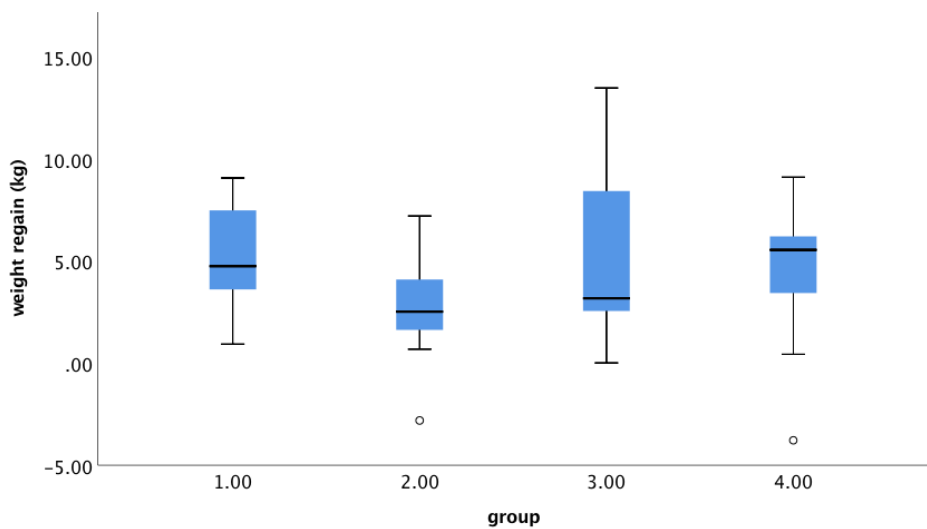
Figure 7. Weight regain in groups of subjects with different combinations of baseline FPG and fibre intake during the FU period. Group 1: baseline FPG < 5.6 mmol/L and fibre intake ≤ median (13.5 g/1000 kcal); group 2: FPG < 5.6 mmol/L and > median fibre intake; group 3: FPG ≥ 5.6 mmol/L and ≤ median fibre intake; group 4: FPG ≥ 5.6 mmol/L and > median fibre intake ( n = 49).